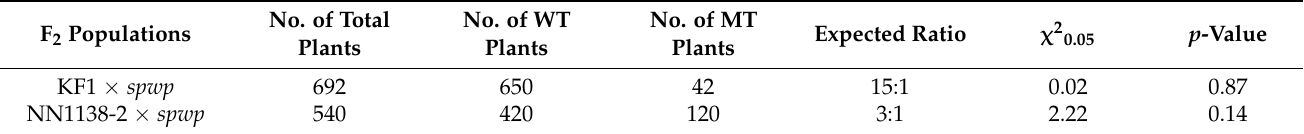
Table 1. Genetic analysis of the spwp mutant in the F 2 populations.